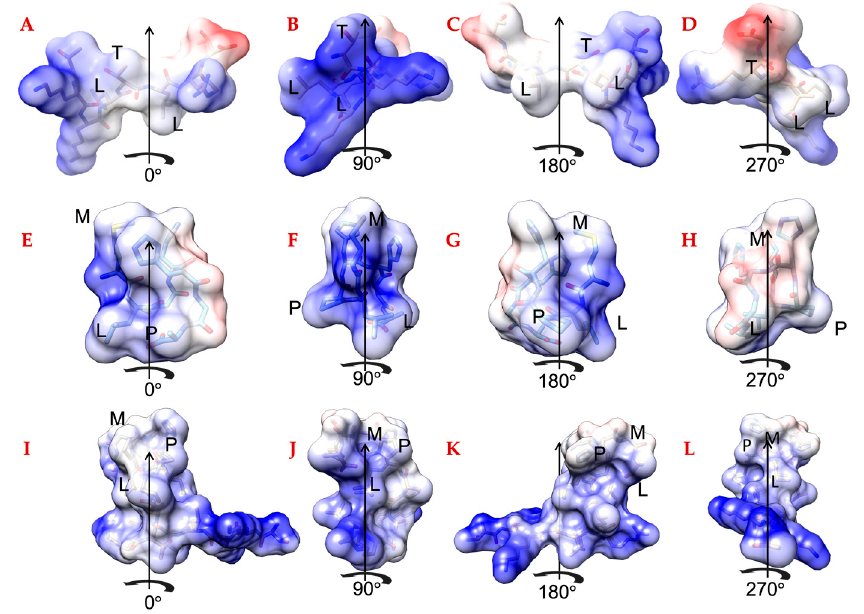
Figure 4. Electronegativity surface rotations of ( A – D ) Collagen-Binding Peptide (TKKLTLRT), ( E – H ) HABP1 (MLPHHGA), and ( I – L ) CBP-HABP1 (TKKLTLRT-APA-MLPHHGA). Underlined residues are labeled to orient the reader.